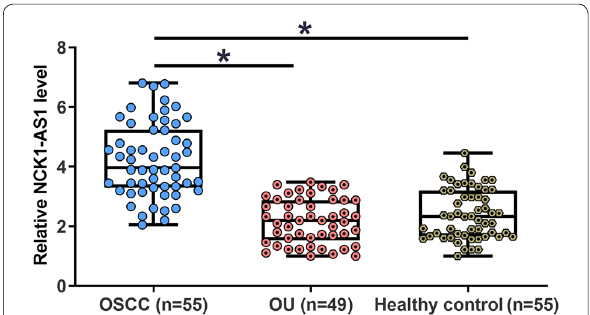
Fig. 1 The expression of NCK1-AS1 was upregulated in early-stage OSCC patients but not in OU patients. The expression of NCK1-AS1 in OSCC patients (n 55), OU patients (n 49) and healthy participants = = (n 55) were detected by qPCR and data were compared by = performing one-way ANOVA and Tukey test. It was observed that the expression levels of NCK1-AS1 were significantly higher in OSCC group in comparison to that in OU and healthy participant